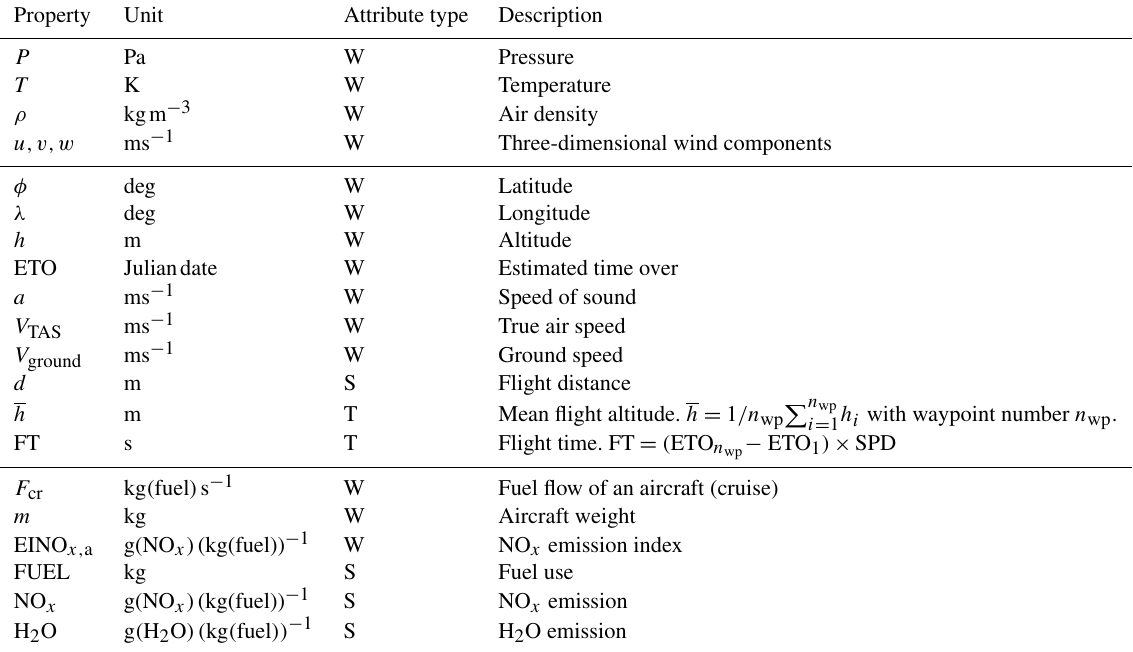
Table 2. Properties assigned to a flight trajectory. The properties of the three groups (divided by rows) are obtained from the nearest grid point of EMAC, the flight trajectory calculation (Fig. 3a), and the fuel/emissions calculation (Fig. 3b), respectively. The attribute type indicates where the values of properties are allocated. “W”, “S” and “T” stand for waypoints (i = 1 , 2 , ··· ,n wp ) , flight segments (i = 1 , 2 , ··· ,n wp − 1 ) and a whole flight trajectory in column 3,